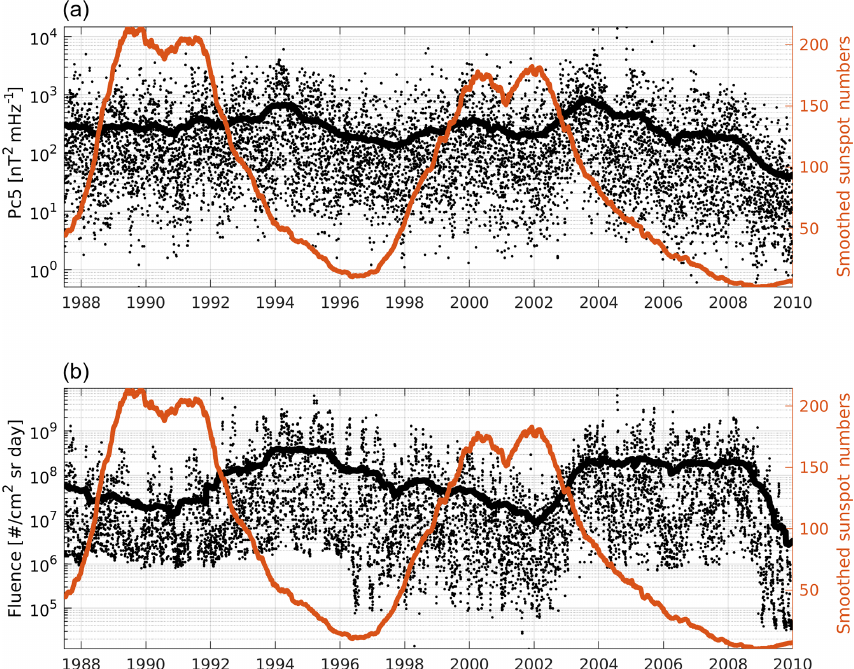
Figure 1. (a) Pc5 power daily values represented as black dots. The thick black curve is the Pc5 power smoothed with a 365d moving average. (b) Fluence daily values represented as black dots. The thick black curve is the fluence smoothed with a 365d moving average. The orange curve corresponds to the yearly smoothed sunspot numbers sequence.